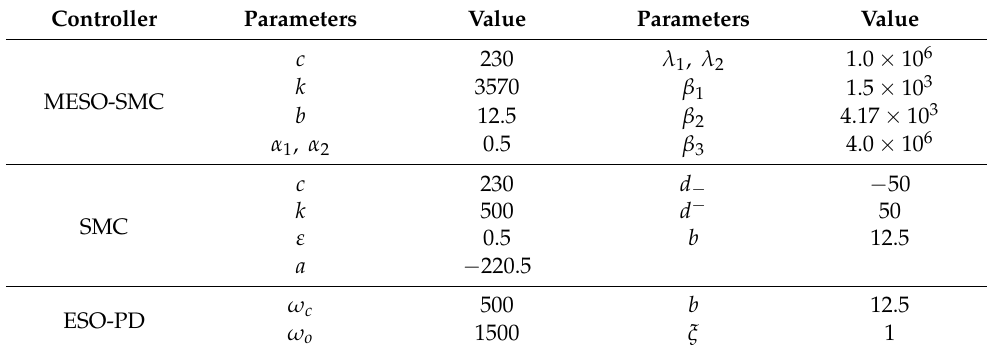
Table 2. Parameters of controllers.